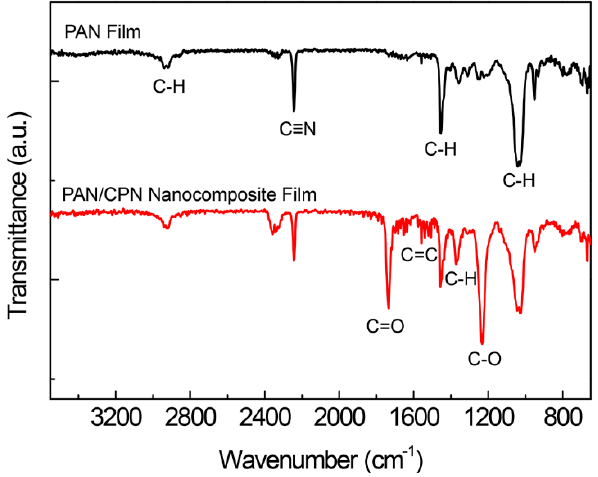
Figure 4. FT-IR spectra of a pristine PAN and a PAN/CPN nanocomposite films.